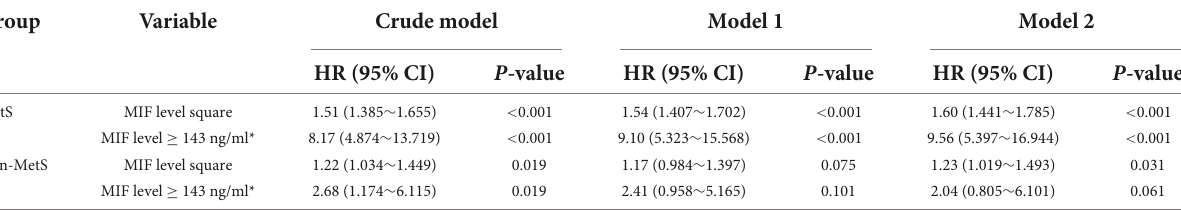
Model1:adjustedforage,male,historyofhypertension/diabetes,BMIandadmissionMIF. Model2:adjustedformodel1+peakhs-TnT,LDL-C,NT-proBNP,LVEF,GensiniscoreandGracescore. MACCE,majoradversecardio-and/orcerebro-vascularevents;HR,hazardratio;CI,confidenceinterval.